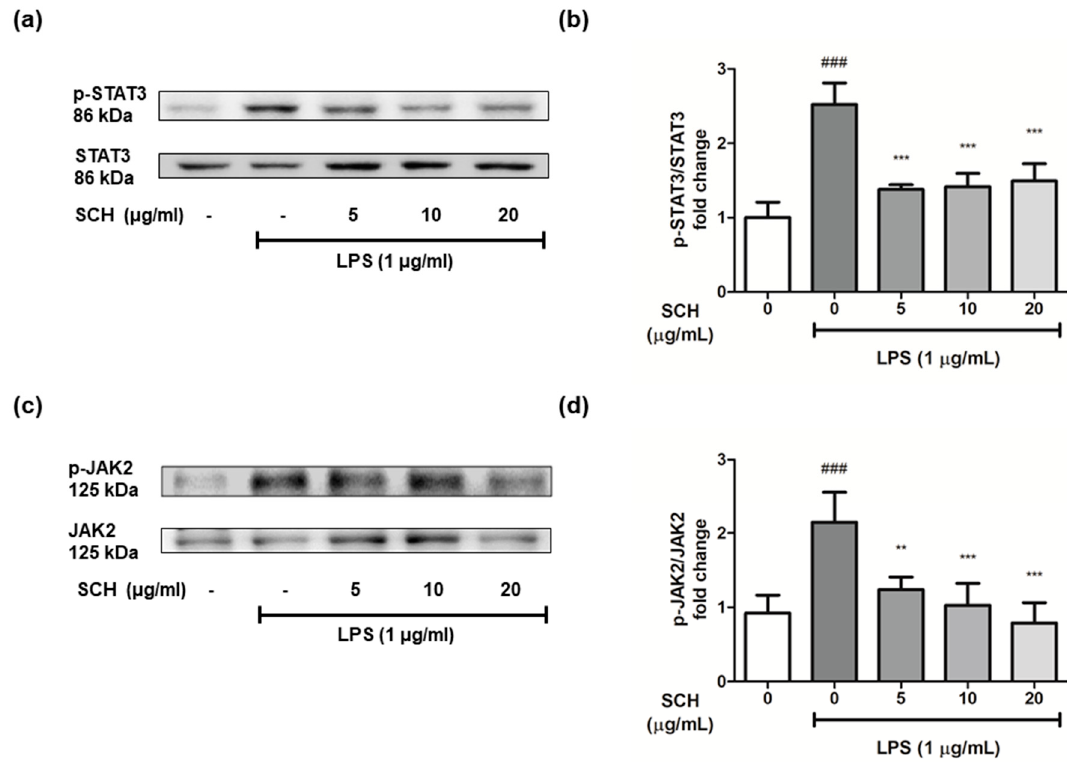
Figure 8. Effect of SCH on the JAK2-STAT3 pathway, as demonstrated by western blot, in LPS-induced Raw 264.7 cells. ( a ) Representative immunoblot images of STAT3 and its phosphorylated forms in cytosol. ( b ) STAT3 band intensities in immunoblots were normalized versus the intensities of those of non-treated cells. ( c ) Representative immunoblot images of JAK2 and its phosphorylated forms in cytosol. ( d ) Band intensities of JAK2 immunoblots were normalized versus those of non-treated cells. Results are presented as means ± SDs. # p < 0.05, ## p < 0.01 vs. non-treated control cells and * p < 0.05, ** p < 0.01 vs. LPS-induced cells.